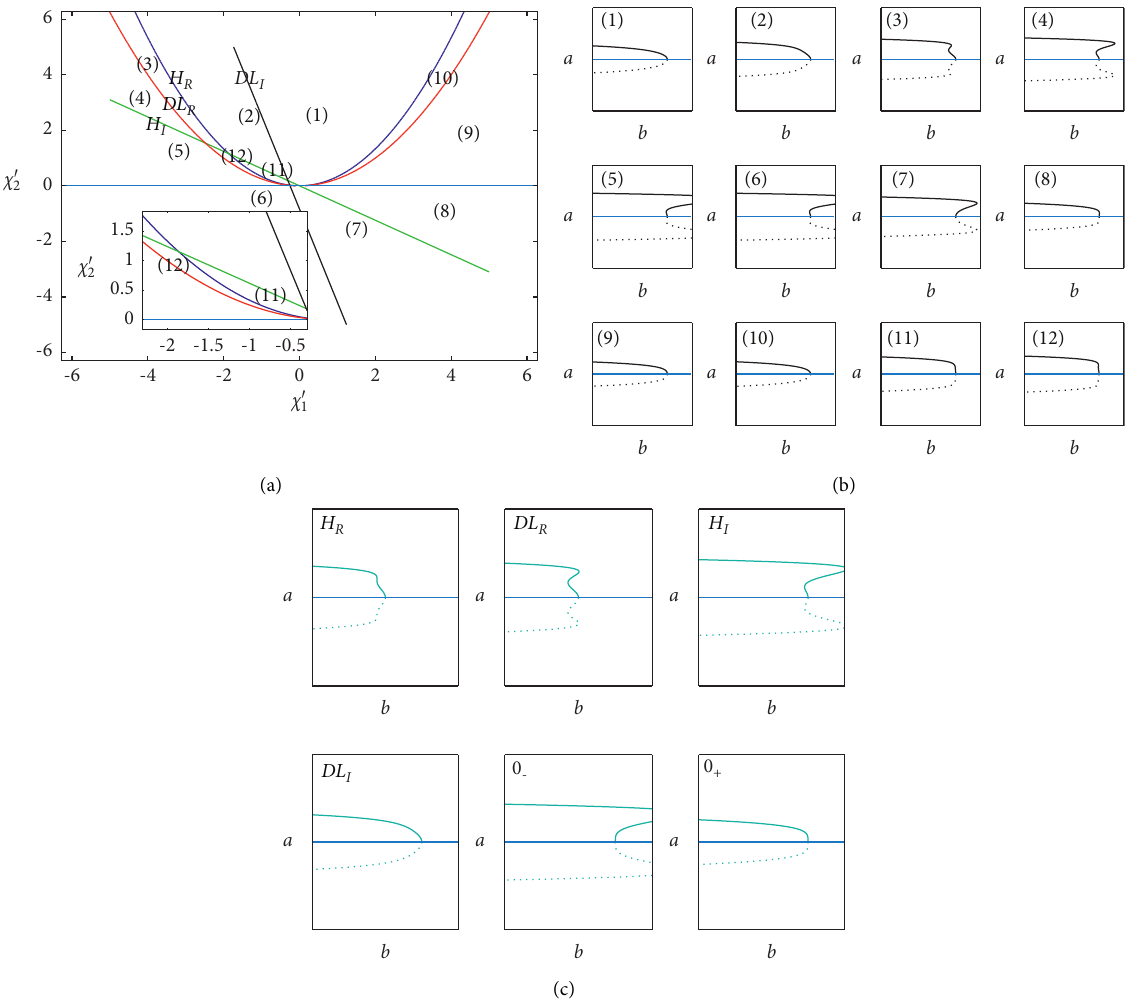
Figure 8: (a) Transition set and (b, c) bifurcation diagrams of the